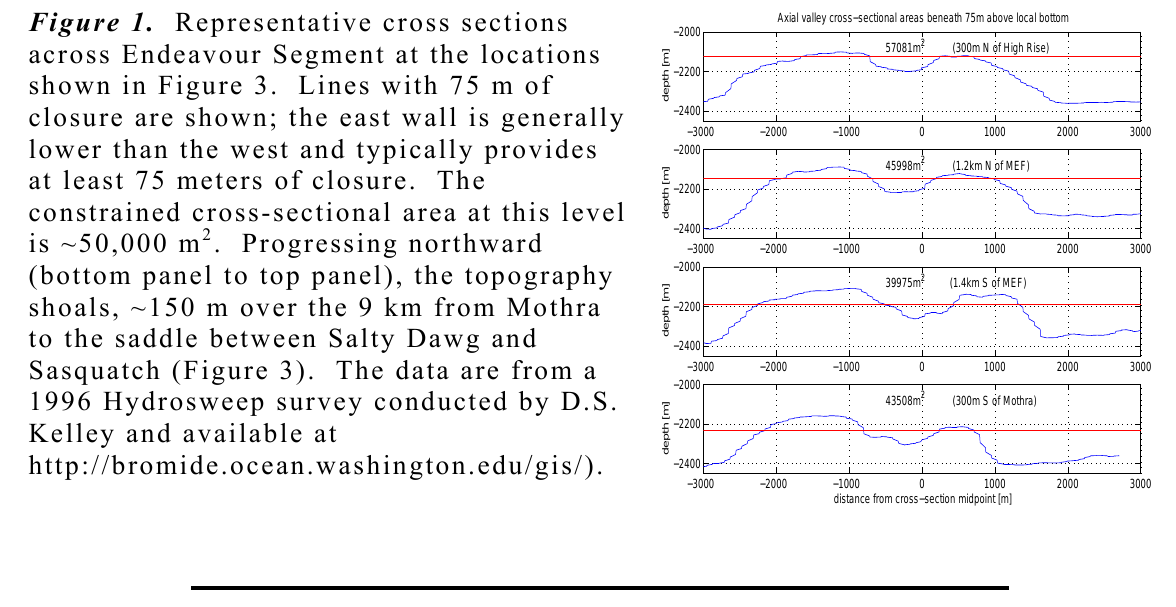
Figure 1. Representative cross sections across Endeavour Segment at the locations shown in Figure 3. Lines with 75 m of closure are shown; the east wall is generally lower than the west and typically provides at least 75 meters of closure. The constrained cross-sectional area at this level is ~50,000 m 2 . Progressing northward (bottom panel to top panel), the topography shoals, ~150 m over the 9 km from Mothra to the saddle between Salty Dawg and Sasquatch (Figure 3). The data are from a 1996 Hydrosweep survey conducted by D.S. Kelley and available